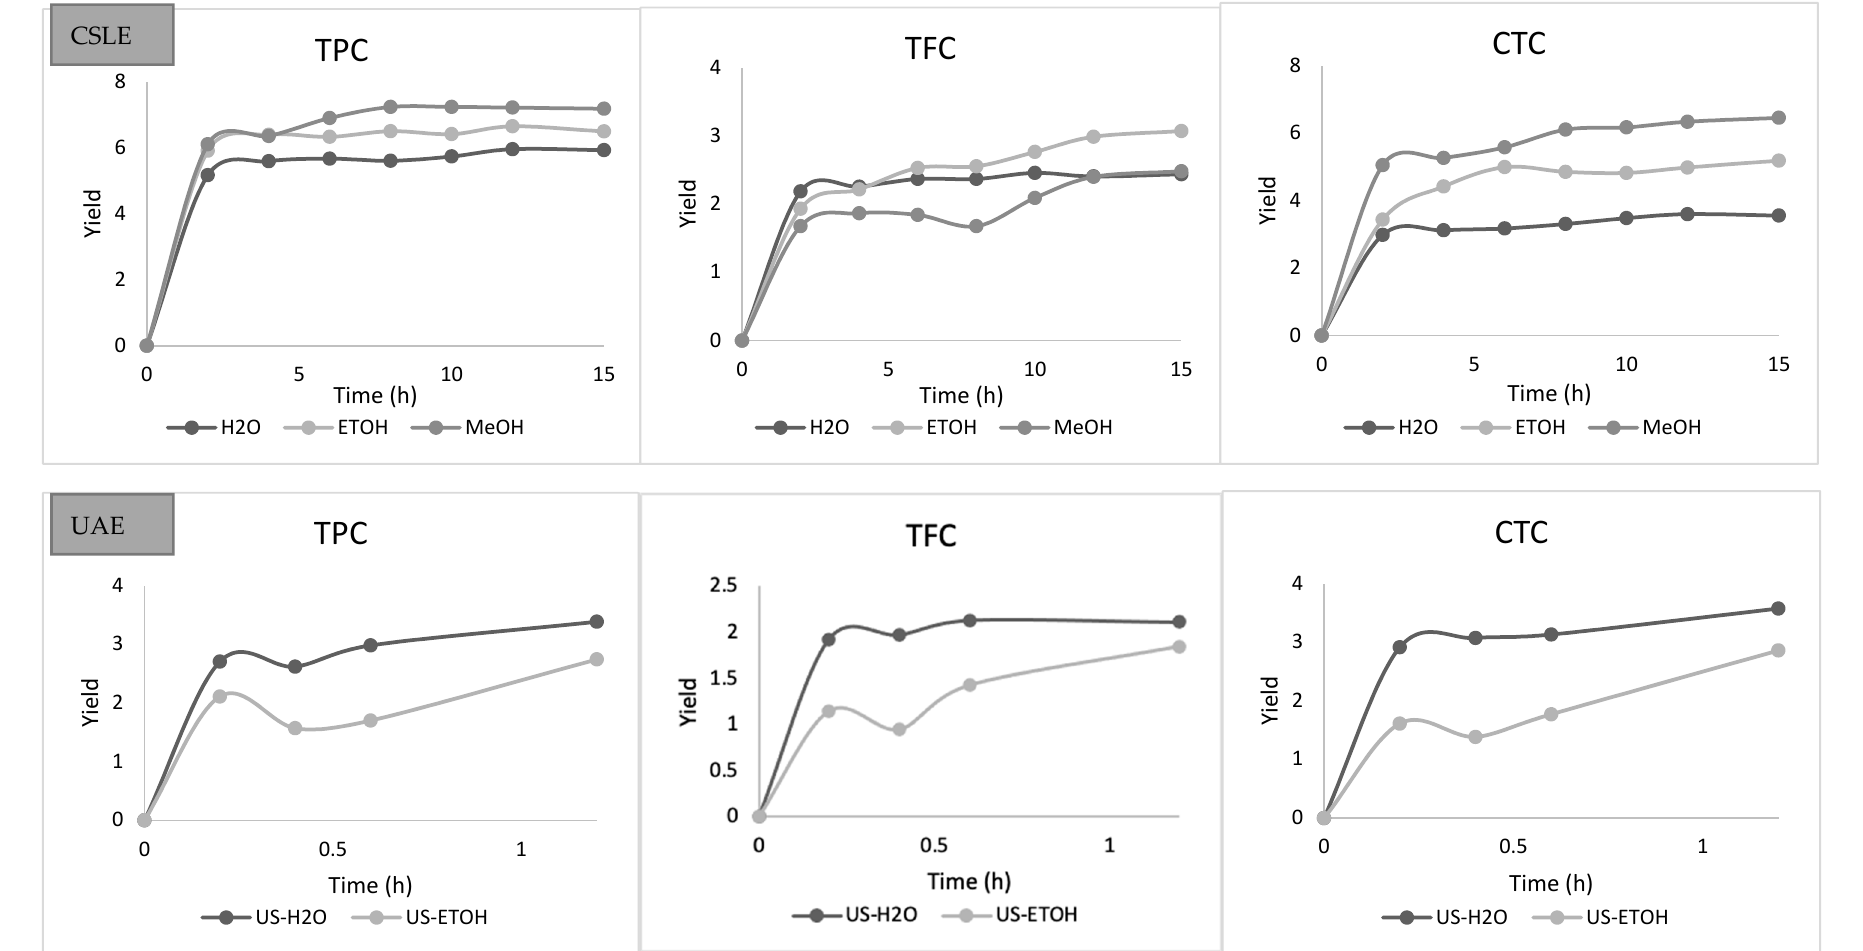
Figure 3. Kinetic yield of total phenolic compounds (TPC), total flavonoid compounds (TFC), and condensed tannin content (CTC) over the extraction time for conventional solid–liquid extraction (CSLE) and ultrasound-assisted extraction (UAE).